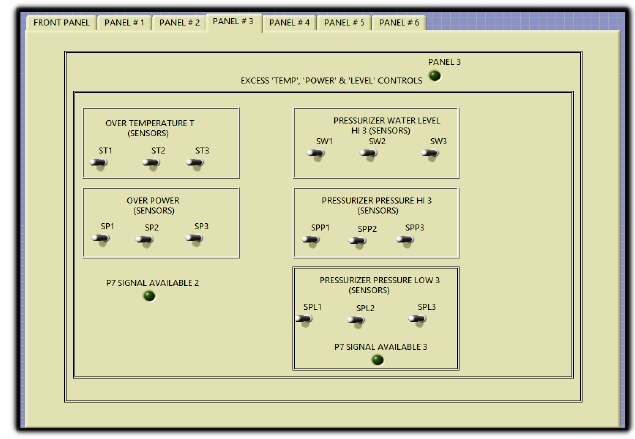
Fig. 10. ACP1000 excess temperature, power and level parameters display system in LabVIEW